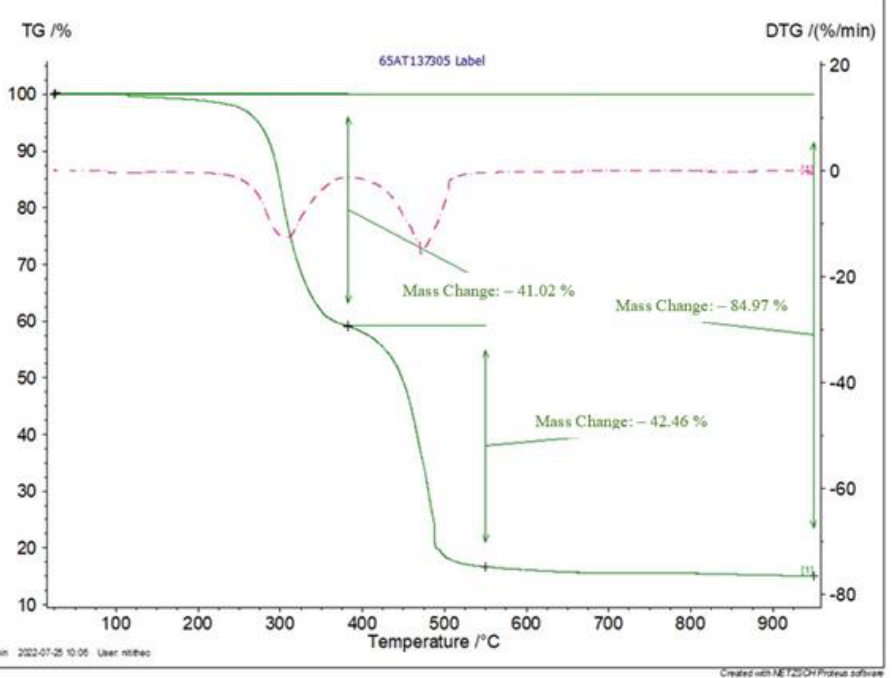
Figure 2. TGA curve of BLWA.